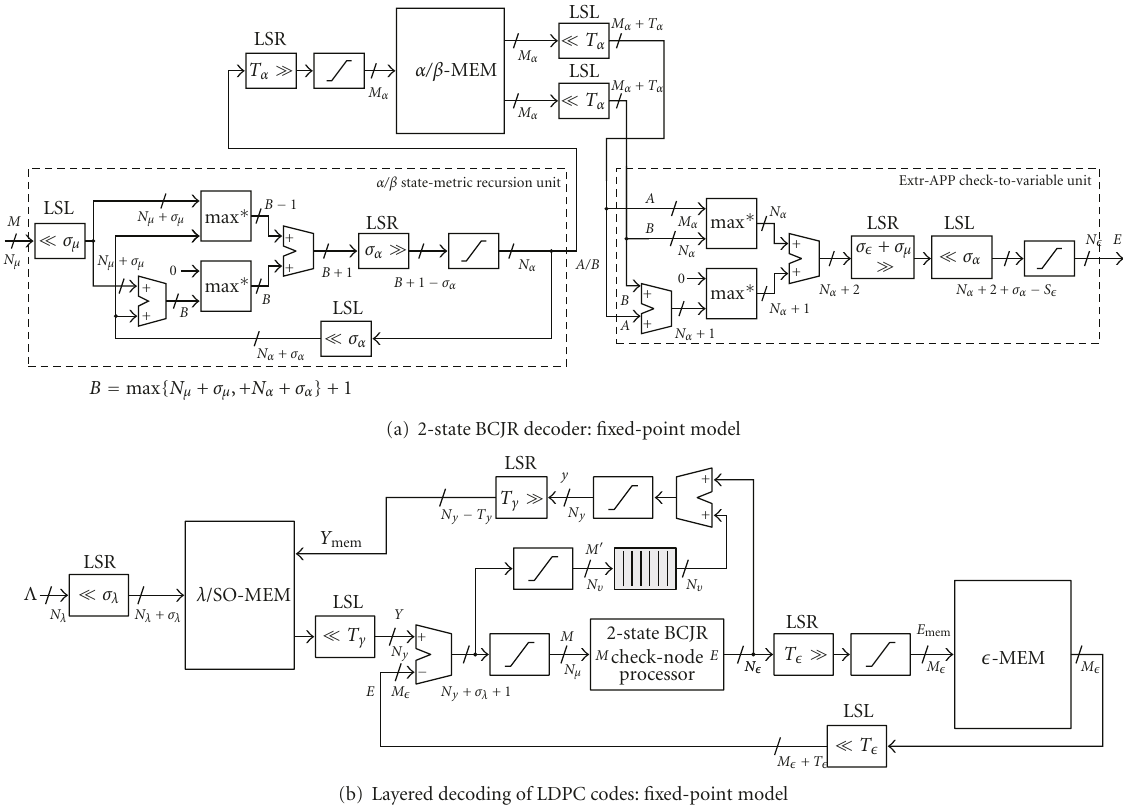
(b) Layered decoding of LDPC codes: fixed-point model Figure 11: The fixed-point model of LDPC codes decoding.